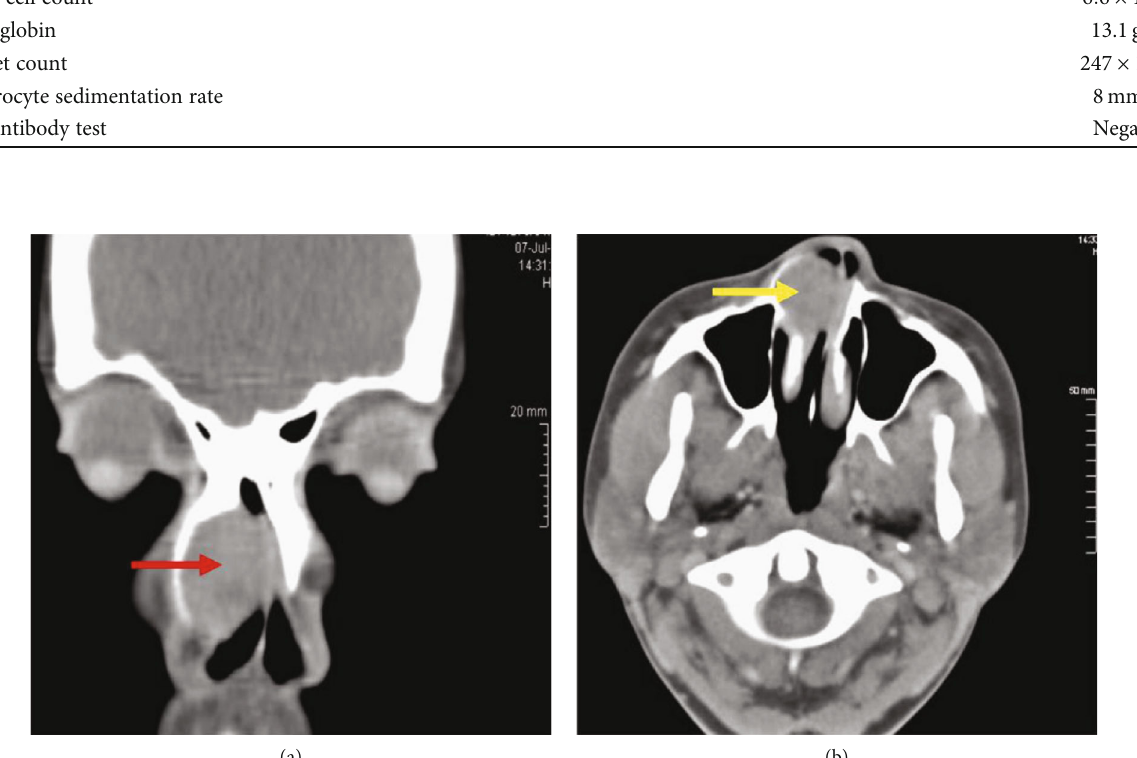
Figure 1: Computer tomographic scan images of the paranasal sinuses. (a) Coronal cut showing a homogenous image fi lling the right nasal cavity (red arrow). (b) Axial cut with contrast showing enhancing lesion compressing the right lateral nasal bone and nasal septum without bone destruction (yellow